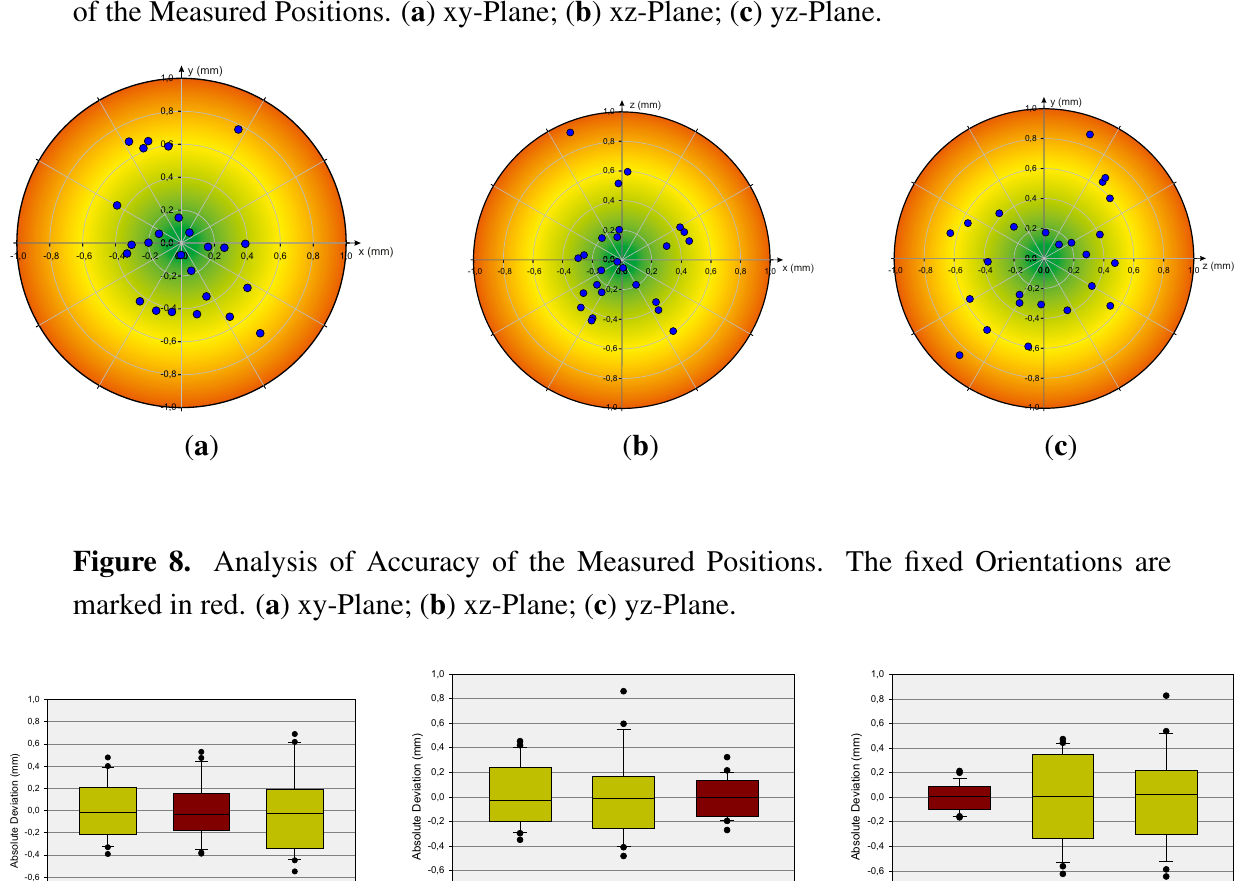
Figure 7. Analysis of Accuracy: Deviation between a Desired 3D Position and the Median of the Measured Positions. ( a ) xy-Plane; ( b ) xz-Plane; ( c ) yz-Plane.